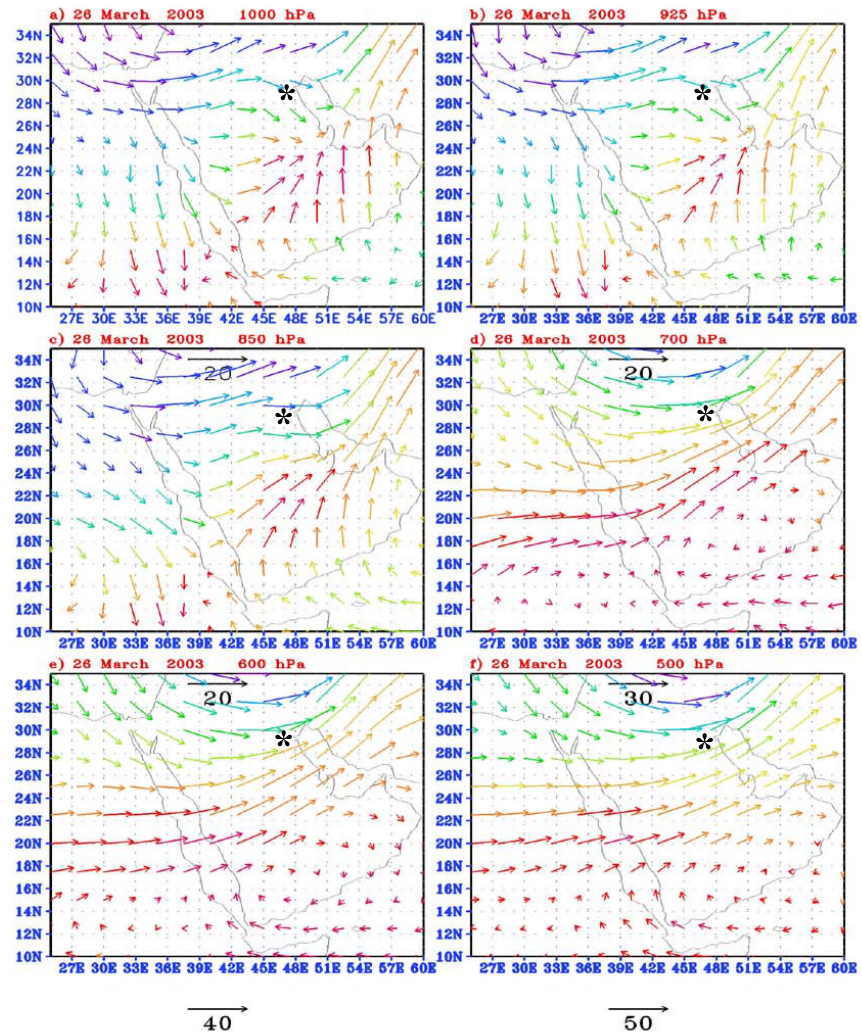
Fig. 4. Wind fields at different geopotential levels on 26 March 2003. The star symbol ( ∗ ) indicates the location of